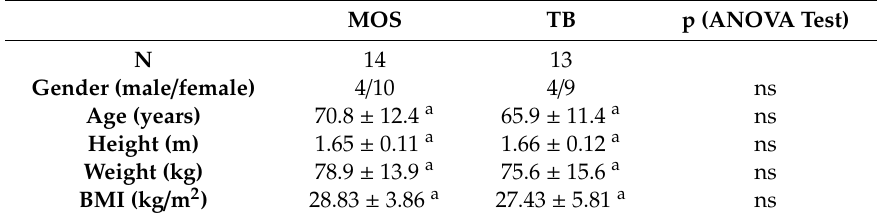
Table 4. Description of study population and evaluation of the homogeneity of the study groups.